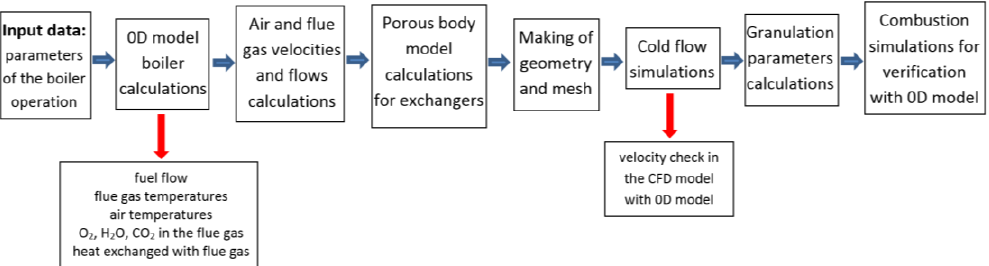
Figure 1. Block diagram for the base procedure for modeling approach of combustion